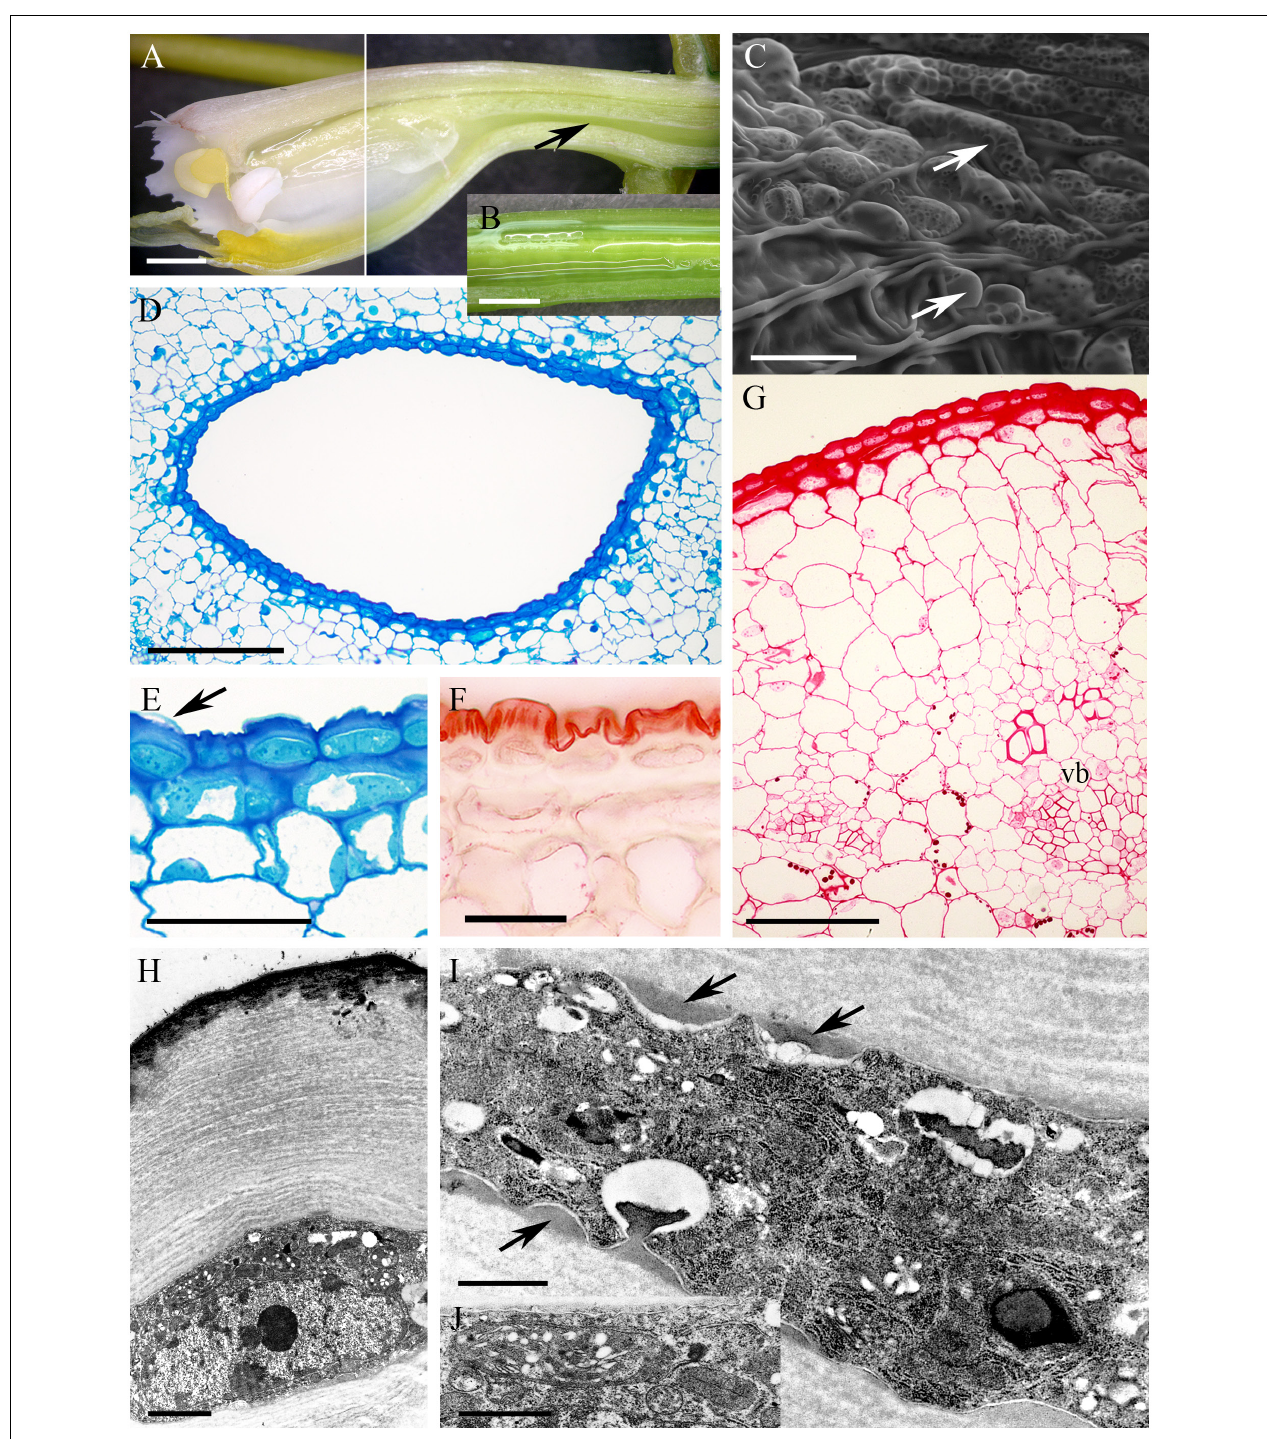
FIGURE 2 | Epidendrum nocturnum . (A) Longitudinal section of anterior part of the flower showing cuniculus (arrow). (B) Detail of cuniculus with copious nectar. (C) Epidermal cells with cuticle ridges and cuticular blisters with secretion (arrows). (D) Transverse section showing epidermis and subepidermal parenchyma of cuniculus (MB/AII). (E) Detail of thick-walled epidermal cells with thin cuticle. Arrow indicates cuticular blister and nectar residues (MB/AII). (F) Cuticle lining cuniculus stained with Sudan III. (G) PAS reaction stains thick walls of epidermis; large starch grains are located close to vascular bundles. (H) Detail of thick outer cell wall and thin cuticle. Note dense protoplast of epidermal cell with large nucleus and plastids. (I) Protuberances (arrows) of thick cell wall of epidermal cell. The electron-dense cytoplasm contains numerous ER profiles and plastids. (J) Detail of cytoplasm of epidermal cell with plastid containing minute starch grains. A,B = 2 mm; C, E,F = 50 µ m; D = 200 µ m; G = 100 µ m; H = 2 µ m; I,J = 1 µ m.